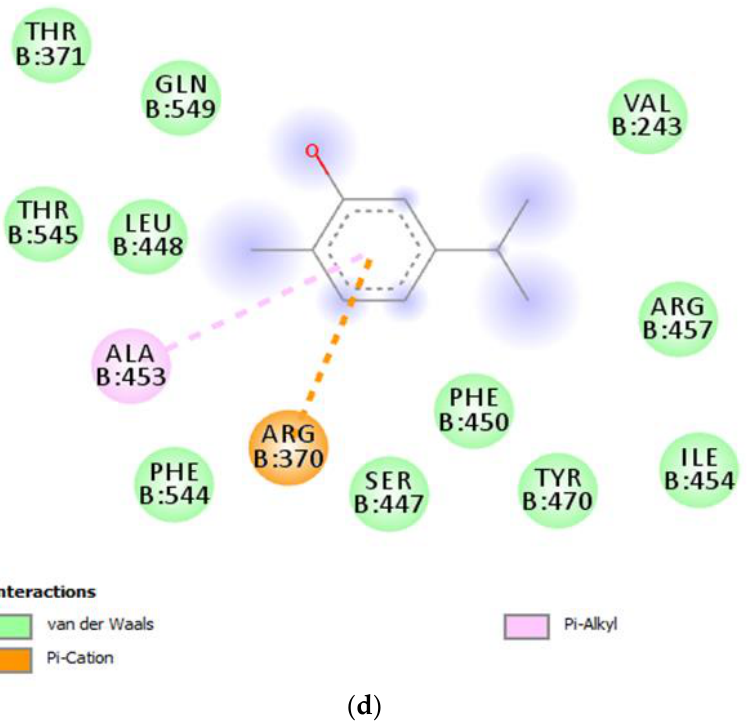
Figure 3. Docked complexes using AutoDock Vina: ( a ) LOX–BHT complex; ( b ) LOX–carvacrol com- plex; ( c ) LOX model–BHT complex; ( d ) LOX model–carvacrol complex; letter codes are amino acids;